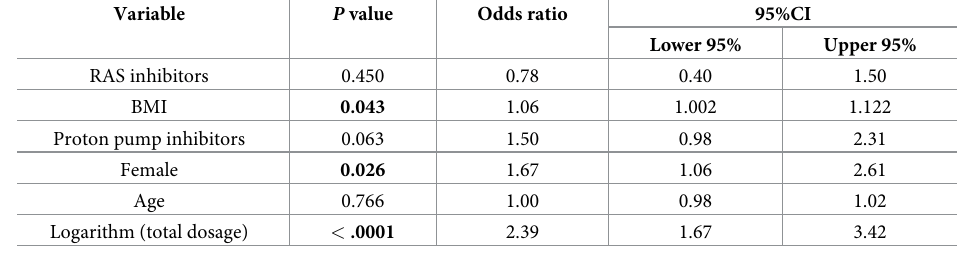
Table 2. Results of multivariate ordered logistic regression analysis for variables extracted by forward selection (n = 322). Variable P value Odds ratio